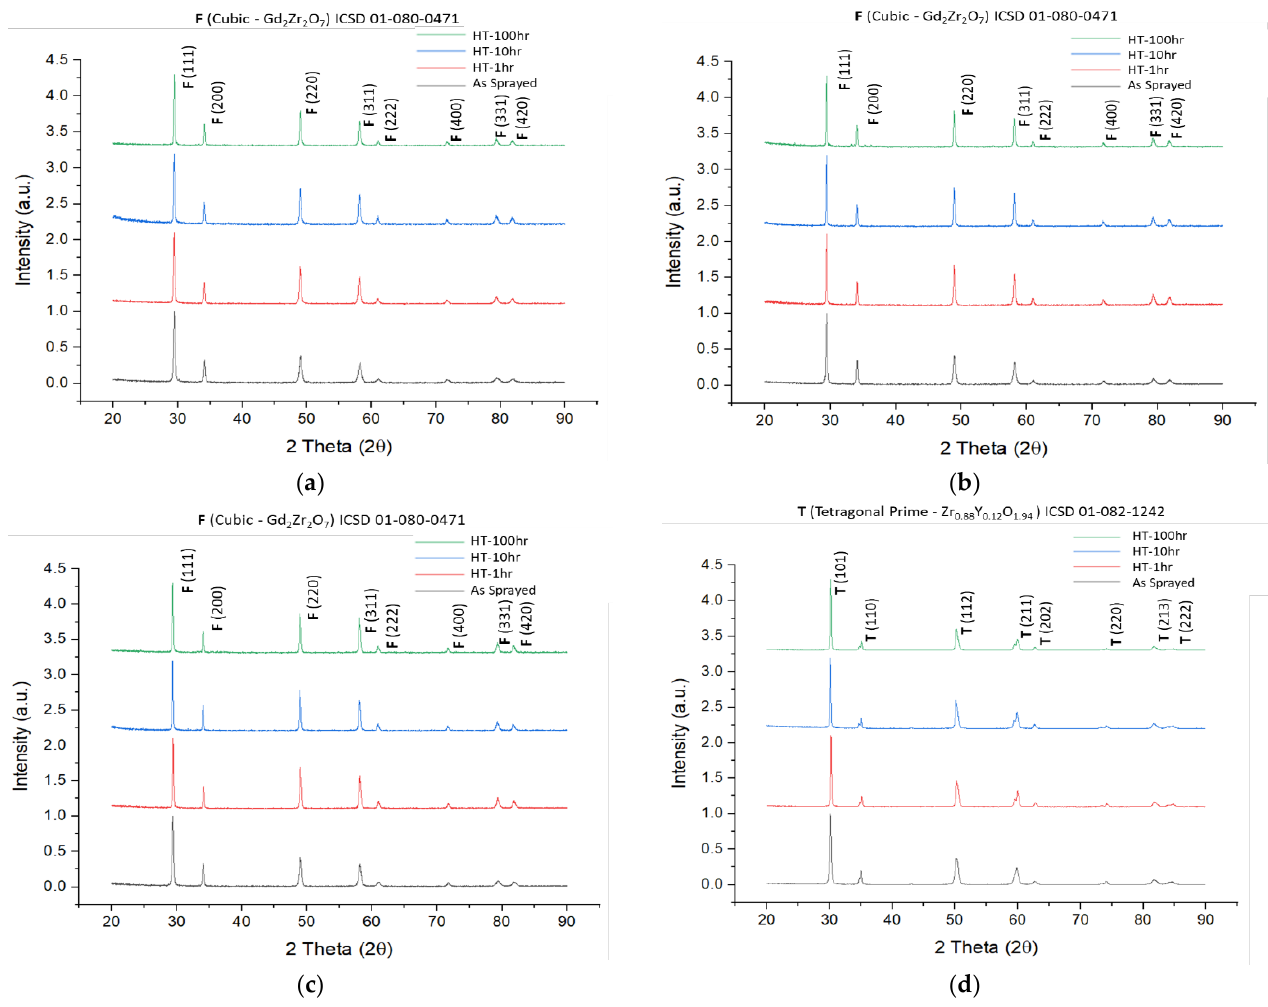
Figure 7. XRD of as-sprayed and heat-treated TBC samples ( a ) double layer, ( b ) triple layered, ( c ) composite layer, ( d ) single layer.